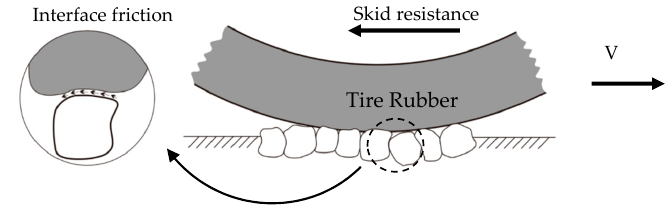
Figure 5. Skid resistance and interface friction.